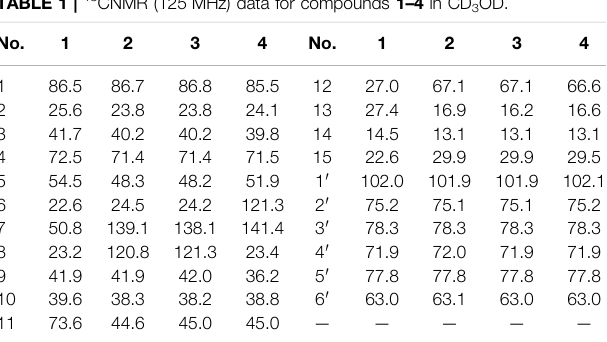
TABLE 1 | 13 CNMR (125 MHz) data for compounds 1 – 4 in CD 3 OD.